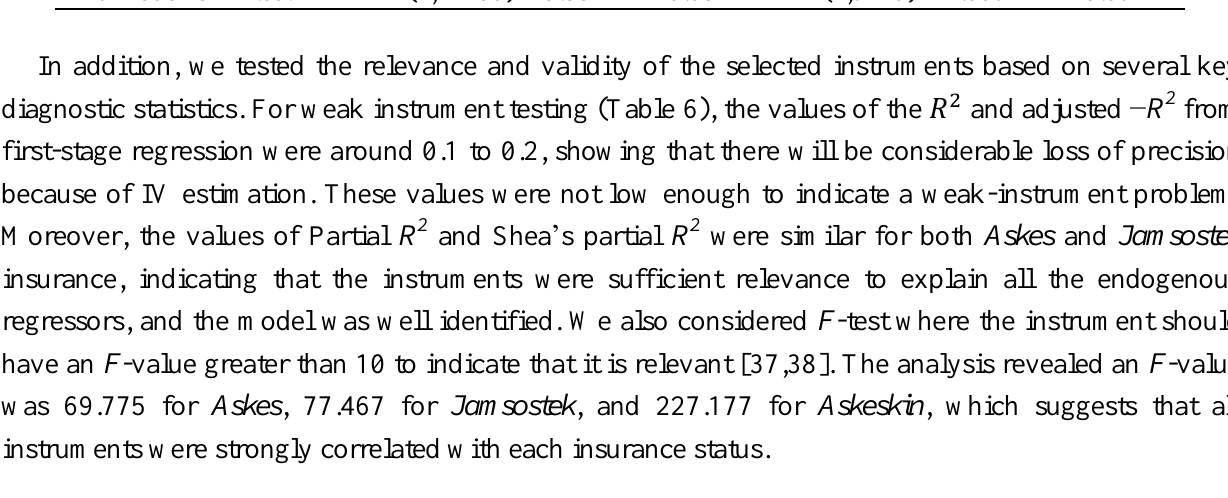
Table 6. Instruments relevance